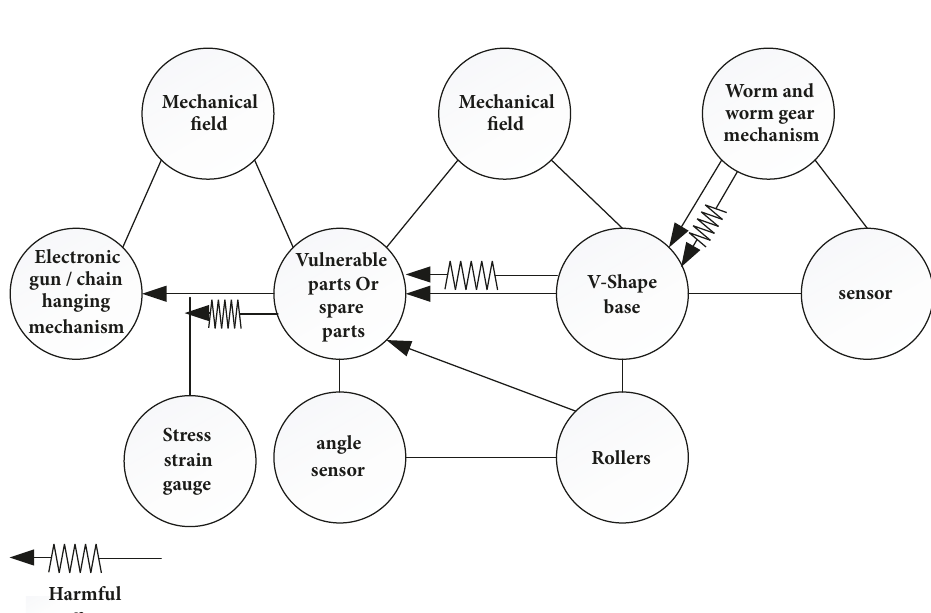
Figure 7: Separation principle solution process.